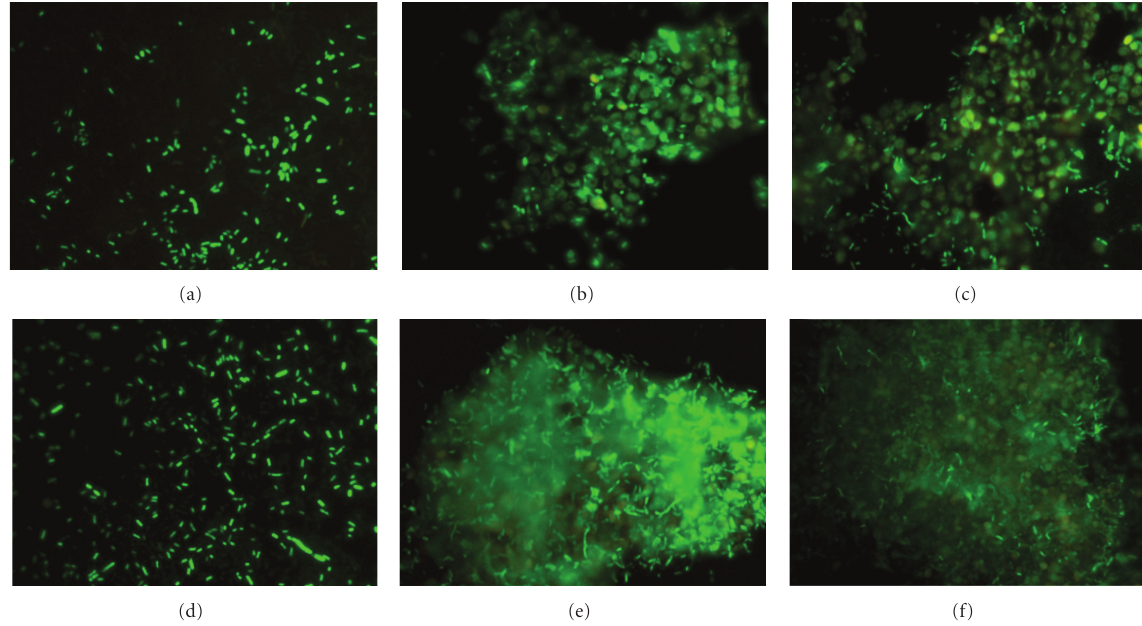
Figure 7: Fluorescence microscopic analysis of adherence to S . cerevisiae . (a) E. coli DH5 α -pGFP: pGEM cells. (d) E. coli DH5 α -pGFP: pGEpmt cells. (b), (c) Adherence of control ( E. coli DH5 α -pGFP: pGEM) cells to S. cerevisiae cell surface beneath. (e), (f) Adherence of E. coli DH5 α -pGFP: pGEpmt cells on S. cerevisiae . Intense green fluorescence indicates expression of gfp -tag, whereas S. cerevisiae cells are seen as yellow colored. (Images taken at 400x.)